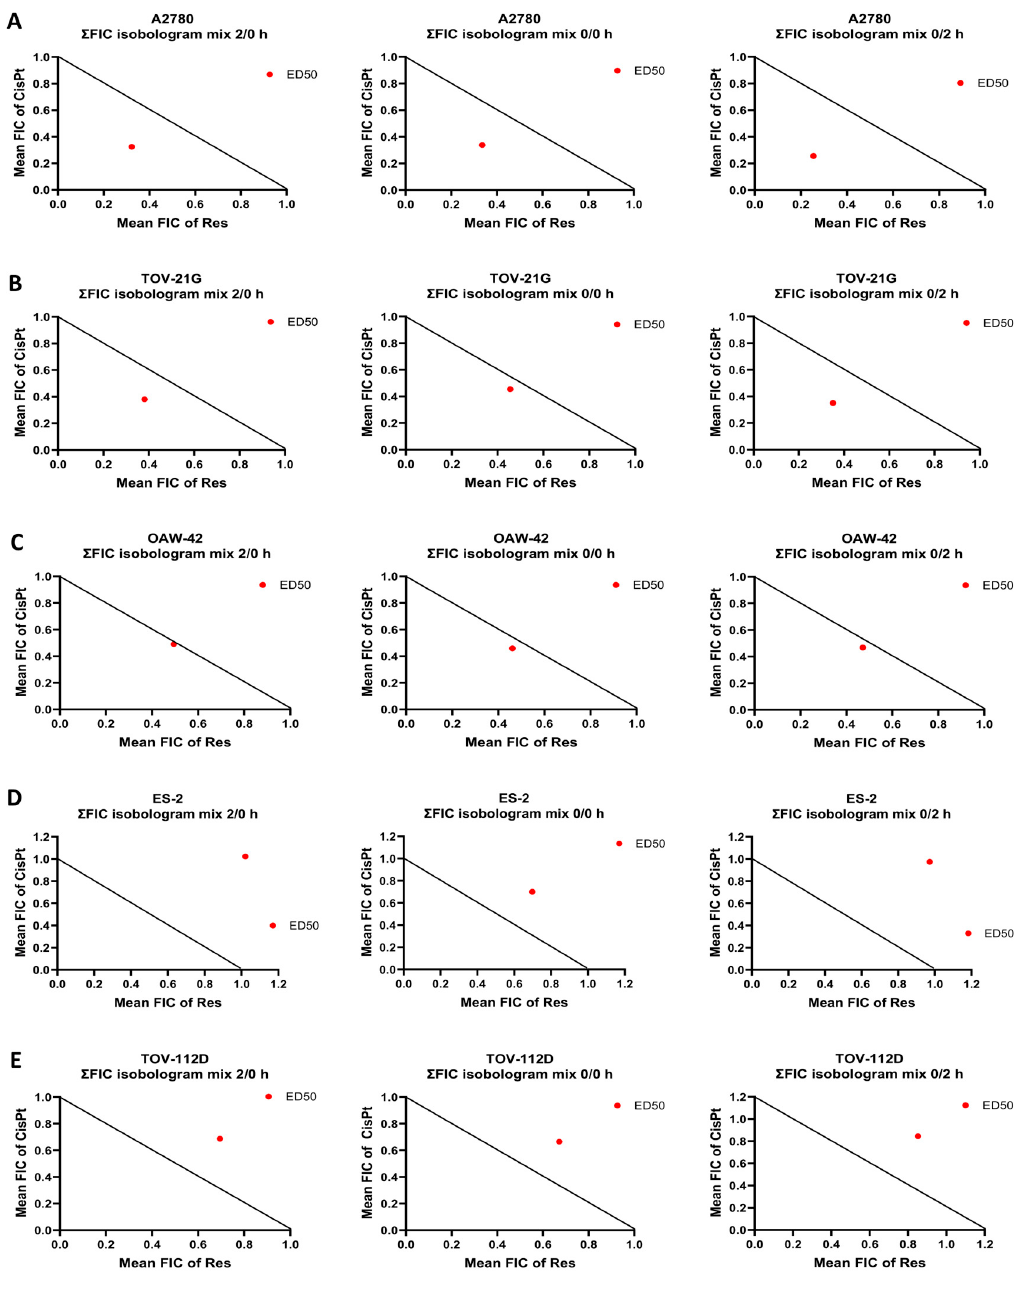
Figure 2. Combination effect of cisplatin with resveratrol in OC cell lines in normoxia. Isobolograms of cisplatin (CisPt) with resveratrol (Res) combination at the ED50 effect dose (median effect dose to inhibit 50% growth cells) for ( A ) A2780; ( B ) TOV-21G; ( C ) OAW-42; ( D ) ES-2; and ( E ) TOV-112 OC cells for three different cell treatment protocols: both compounds were added at the same time (mix 0/0 h), Res given 2 h before CisPt (mix 2/0 h), or given 2 h after CisPt (mix 0/2 h). The individual doses of CisPt and Res to achieve 50% growth inhibition (black straight line) were plotted on the x- and y-axes. Isobolograms show a synergistic effect between drugs when the red data point was located below the straight line, an antagonistic e ff ect when the red data point was located above the straight line, and an additive e ff ect when this point was located on the line. The results of three experiments are presented.